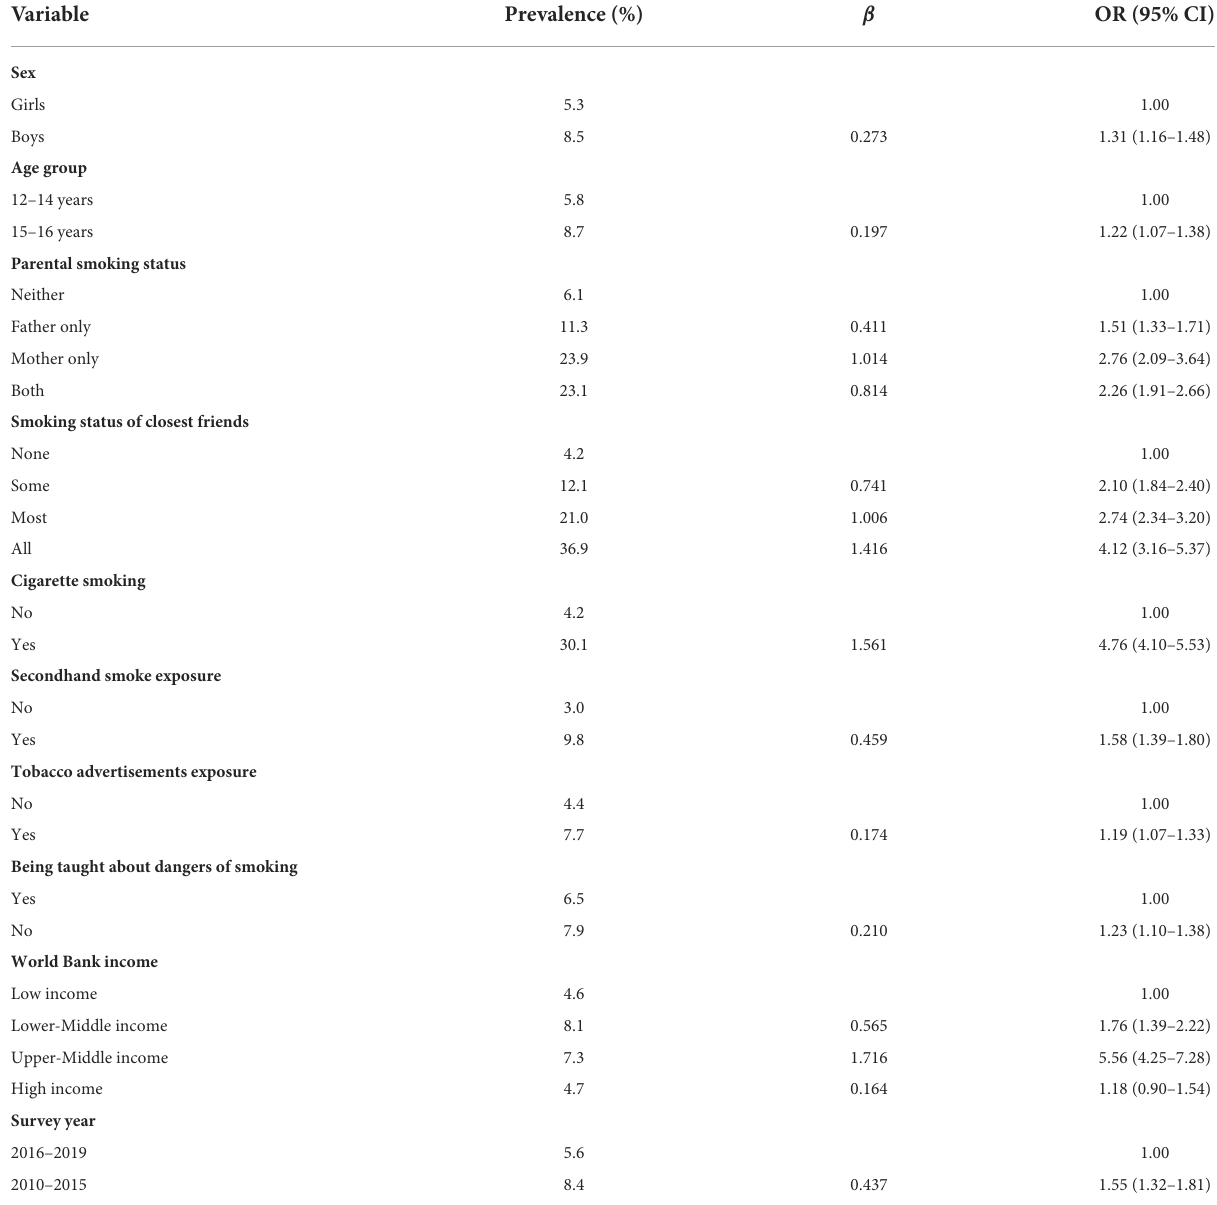
TABLE 4 Factors associated with waterpipe smoking (on ≥ 1 day during the past 30 days) among adolescents aged 12–16 years in 73 countries/territories,